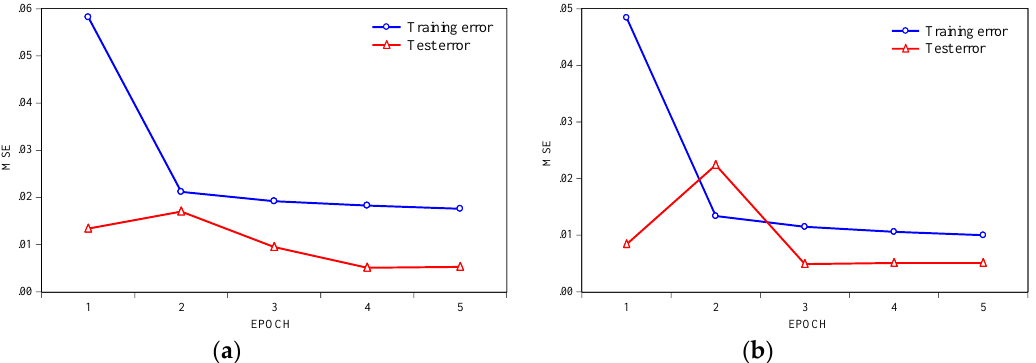
Figure 5. Training process of error change. ( a )Error comparison of the first epoch; ( b ) Error of the final epoch.